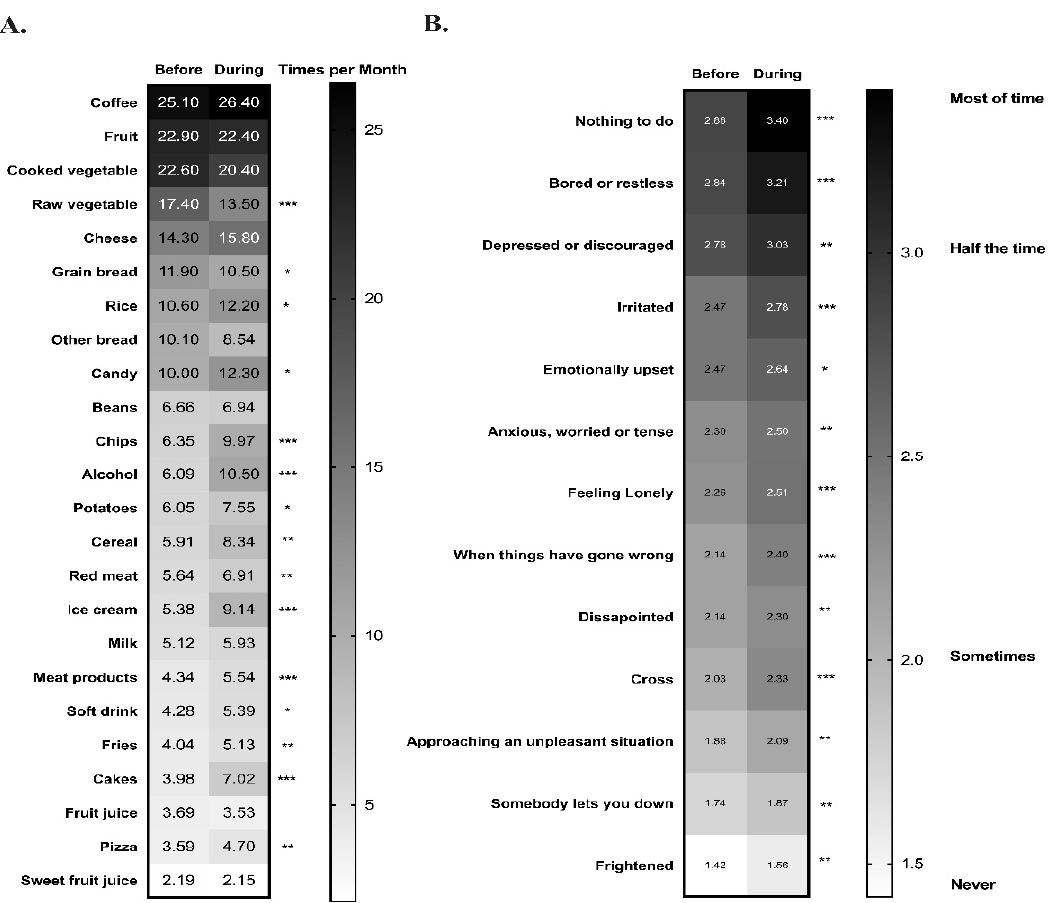
Figure 2. Heat map indicating changes in food consumption and emotional eating. Means of the frequencies of foods consumed ( A ) and emotional eating ( B ) were reported for before school closures (before 16 March) and during school closures (until 26 June). Darker colored cells represent higher frequency of the parameter measured. Wilcoxon signed-rank tests were used, and *, **, *** indicating p -value < 0.05, 0.005, 0.0005,